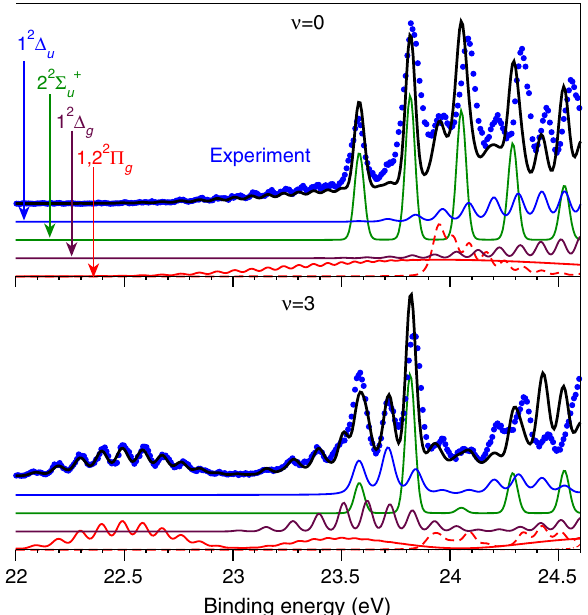
FIG. 5. The details of the experimental and theoretical RPE spectra (see Fig. 4) in the binding-energy range of 22–24.6 eV. The spectral structure for the resonant excitation to (cid:3) ¼ 0 (upper plot) and (cid:3) ¼ 3 (lower plot) sublevels of the core-excited state are shown. The profiles of the individual states of different symmetries are shifted horizontally for reasons of clarity (see the labels in the upper panel). The total theoretical spectrum is shown by a solid black line, while blue dots represent the experimental spectrum. Theoretical contributions for only the most important states are shown. The colors and line types of the individual electronic states are the same as those used for the PECs in Fig. 2 (as in Figs. 6 and